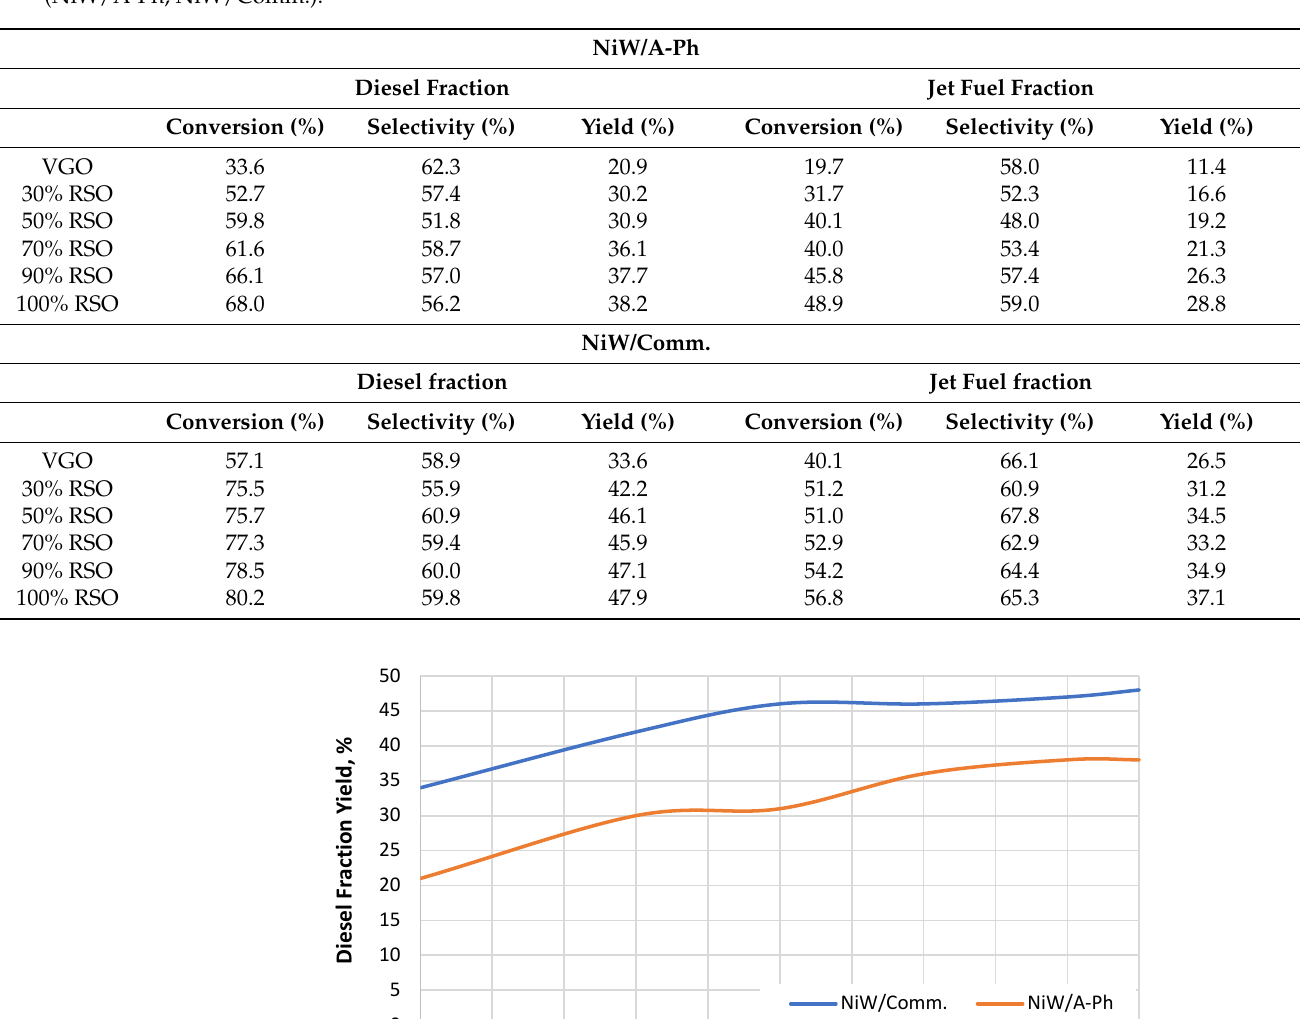
Table 3. Conversion, selectivity, and yield for raw fuel fractions (diesel, jet fuel) produced using both tested NiW catalysts (NiW/A-Ph, NiW/Comm.).